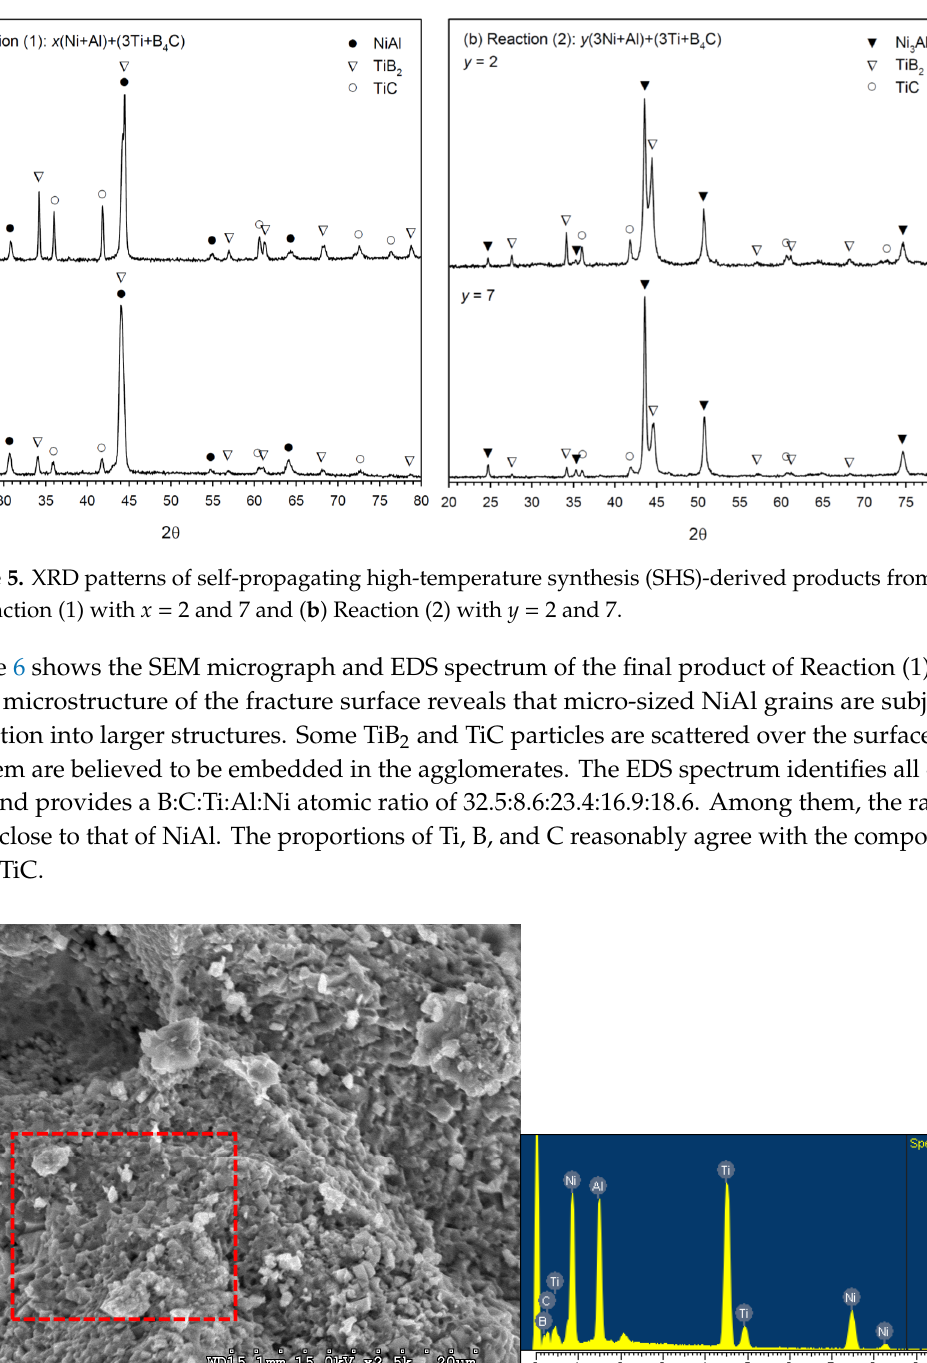
Figure 6. SEM micrograph and EDS spectrum of the 3NiAl + 2TiB 2 + TiC composite synthesized from Reaction (1).